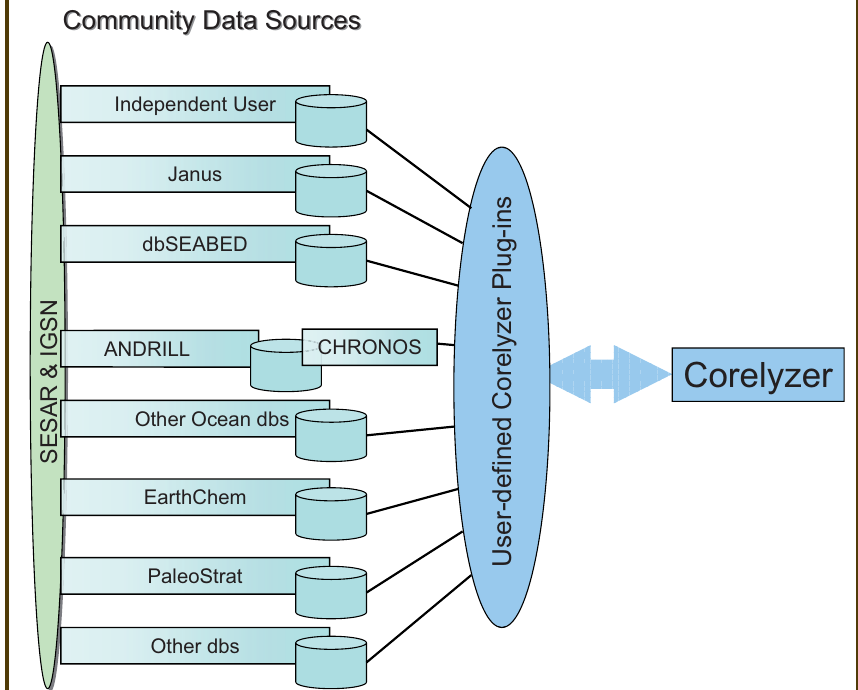
Figure 2. Projected interfaces between user community data bases and CoreWall suite. System for earth sample registration (SESAR) and international geosample number (IGSN) are sample registration systems, assigning unique id’s to physical geological